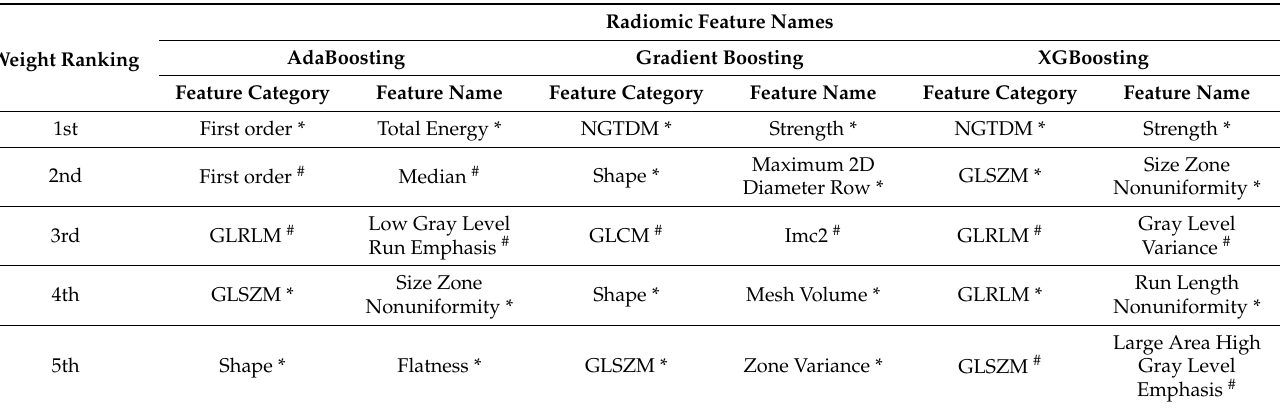
Table 4. Top five weighted radiomic features of trained tree-based ensemble classifiers. The feature names are based on the Pyradiomics library used for research